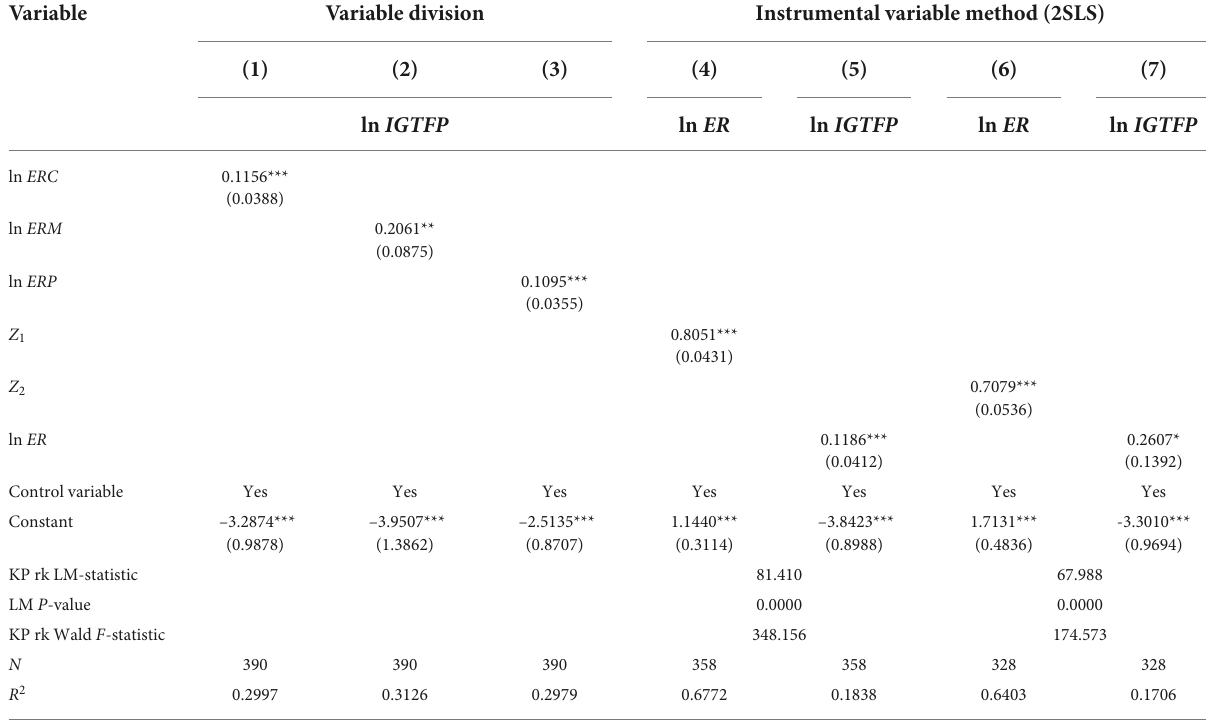
TABLE 4 Robustness test results of sub-indicators and replacement